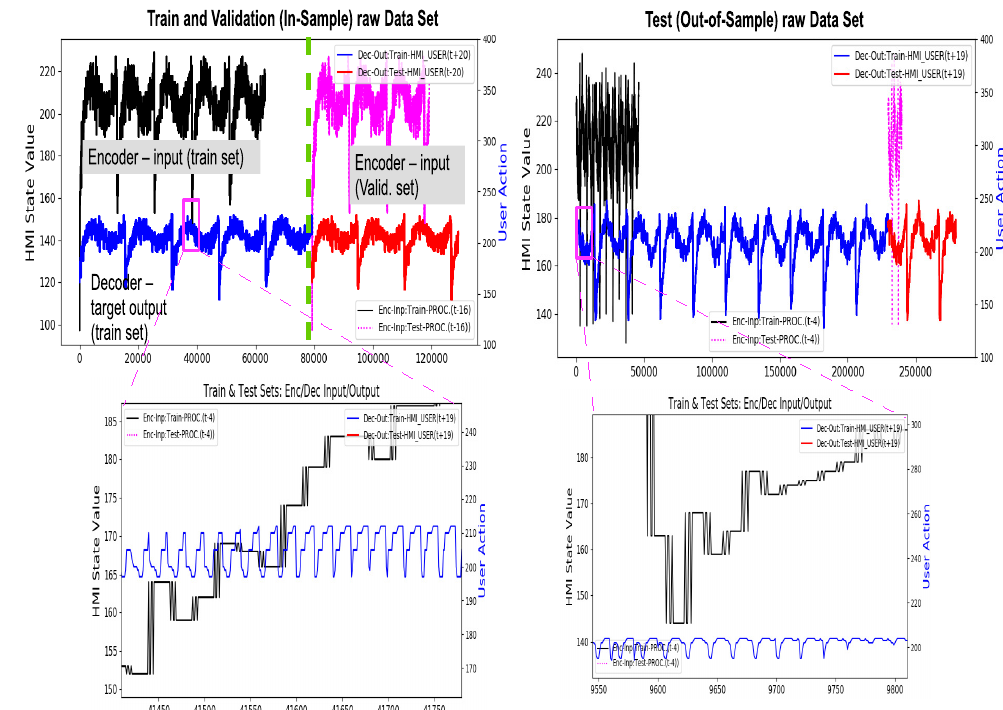
Figure 15. Raw Training/Validation and Test data sets for doing In-Sample and Out-of-Sample model performance evaluation, respectively. Below each plot are zoomed-in sections of the over-all sequence patterns to show the underlying patterns. Test data set uses a slightly slower HMI operator response: The PI controller’s integral constant is changed to 6 steps compared to 4 steps used for original training